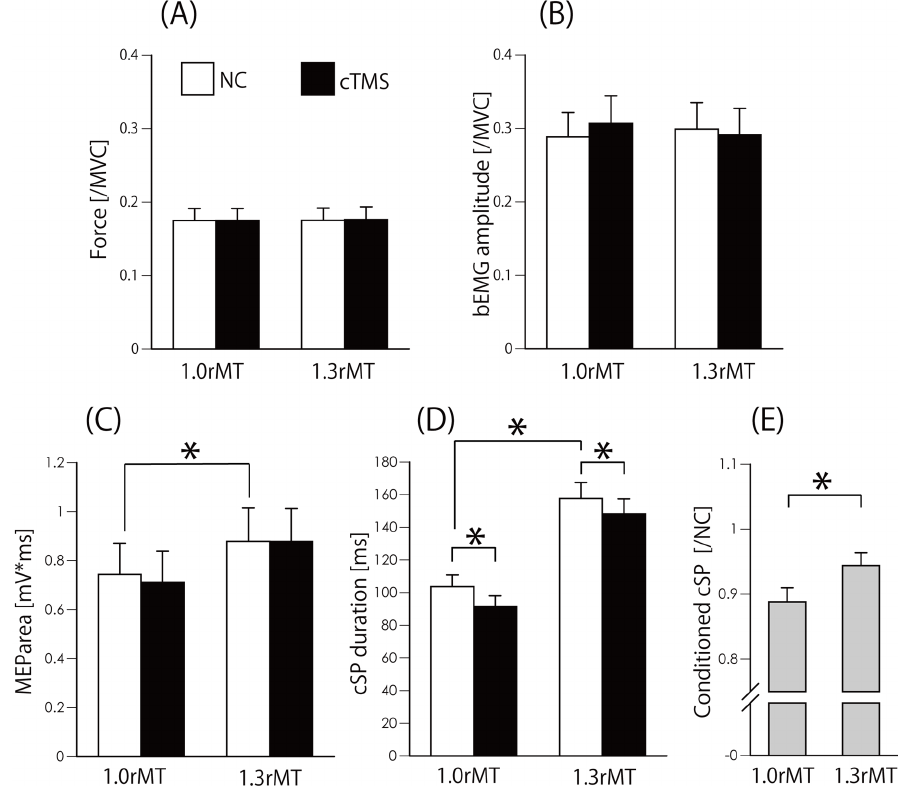
Figure 3. Actual output force (/MVC) ( A ), bEMG amplitude (/MVC) ( B ), MEParea (mV*ms) ( C ), cSP